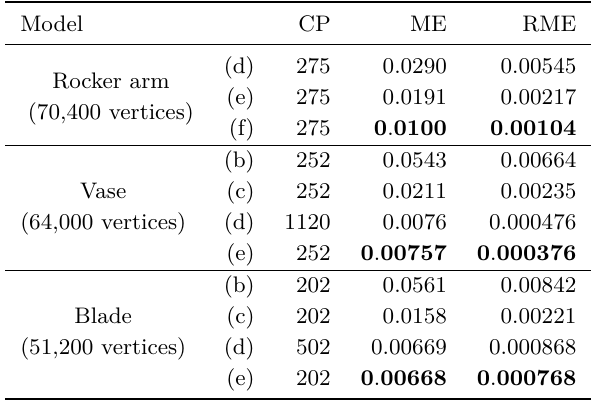
Table 1 Summary of models: number of vertices, number of control points (CP), maximum error (ME), and root mean error (RME)